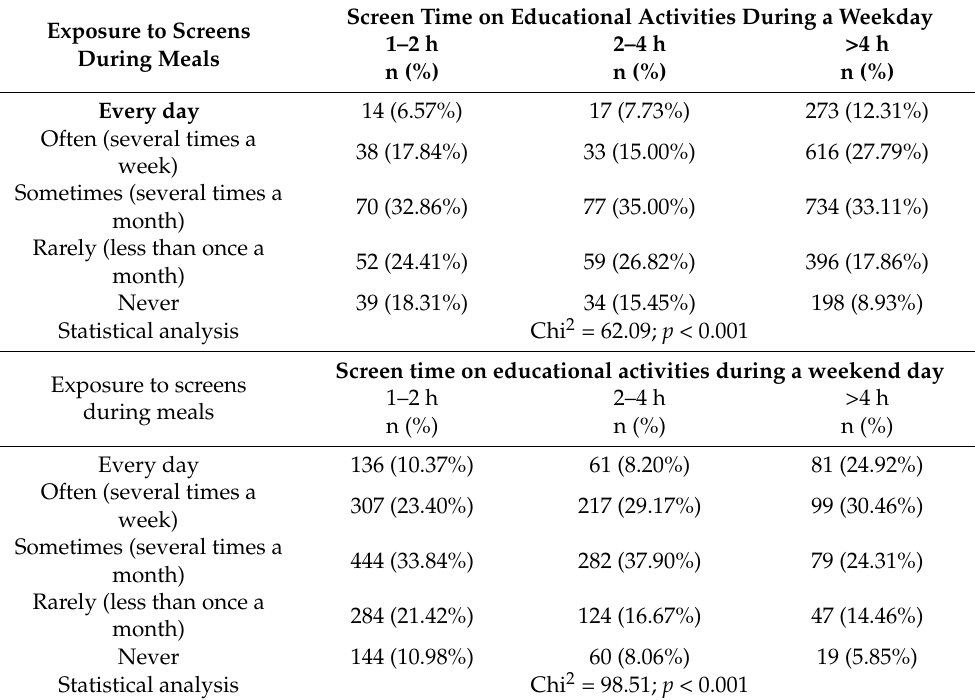
Table 3. Association between the exposure to screen during meals and screen